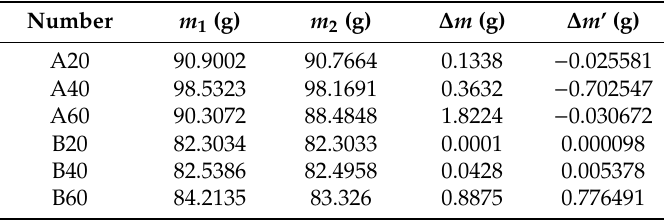
Table 6. Mass losses of specimens. m 1 is the original mass; m 2 is the post-experiment mass; ∆ m is the mass variations; ∆ m ’ is the di ff erences compared with simulations.